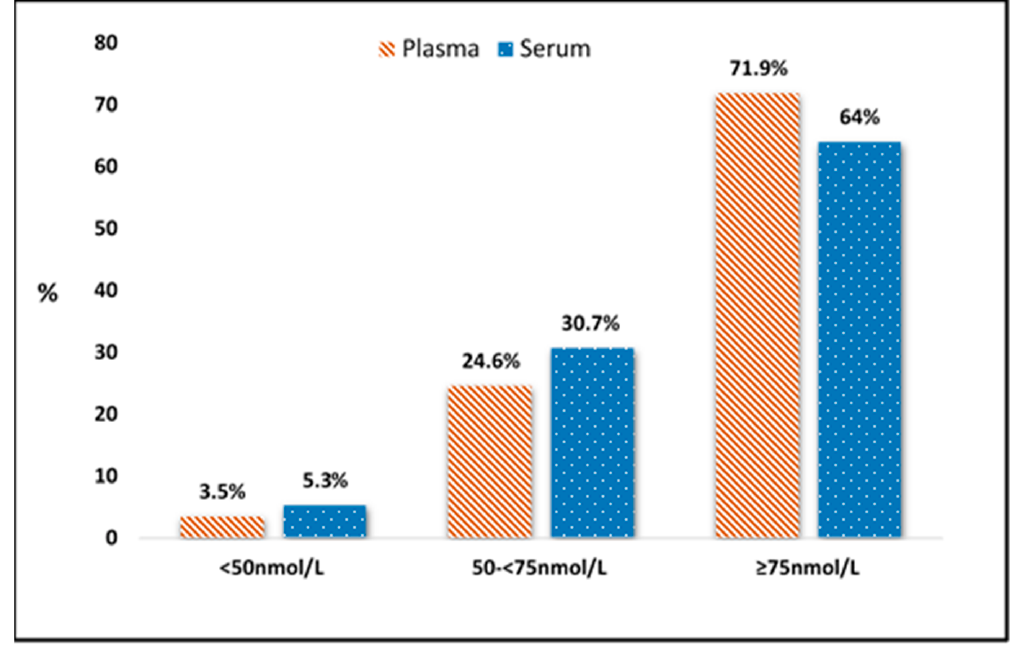
Figure 3. Vitamin D status category based on serum and plasma samples from women between 12–25 weeks gestation using LC-MS/MS.